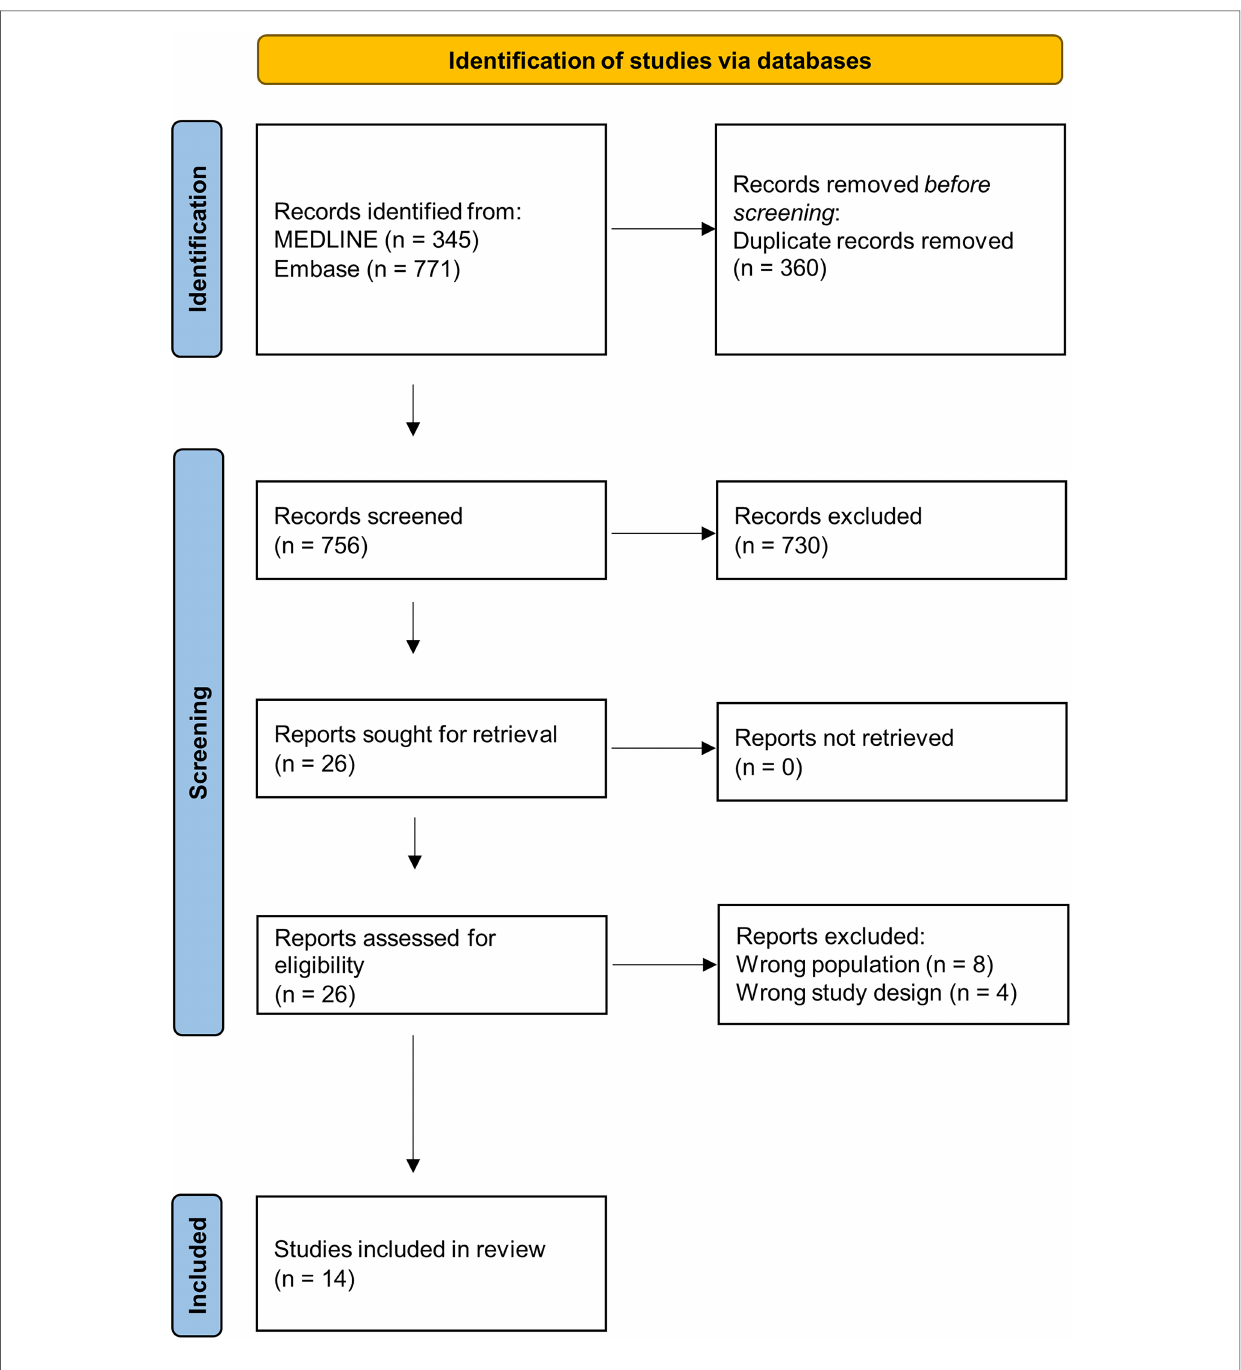
FIGURE 1 Flow chart of the systematic search of the literature and study selection